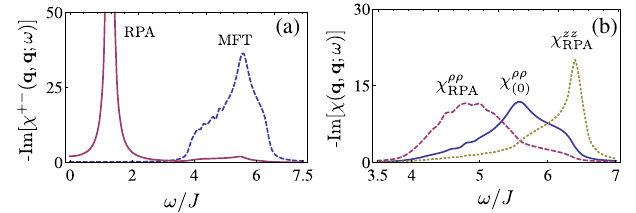
FIG. 5. Imaginary part of the MFT and RPA density, longi- tudinal spin, and transverse spin susceptibilities for a lattice size of 40 × 40 . Other parameters are as in Fig. 4. (a) Imaginary part of the transverse spin susceptibility for the MFT case χ þ − ð q ; q ; ω Þ of Eq. (42) (dashed line) and for the RPA case ð 0 Þ ð q ; q ; ω Þ of Eq. (47) (solid line). (b) RPA density suscep- χ þ − RPA ð q ; q ; ω Þ of Eq. (44) (dashed line) and RPA longi- tibility χ ρρ RPA ð q ; q ; ω Þ of Eq. (45) (dotted line). tudinal spin susceptibility χ ρρ RPA ð q ; q ; ω Þ (solid line) coincides Note that in the MFT case, χ ρρ ð 0 Þ ð q ; q ; ω Þ ; see Eqs. (39) and (40). However, the with the MFT χ zz ð 0 Þ RPA renormalizes these two susceptibilities differently.